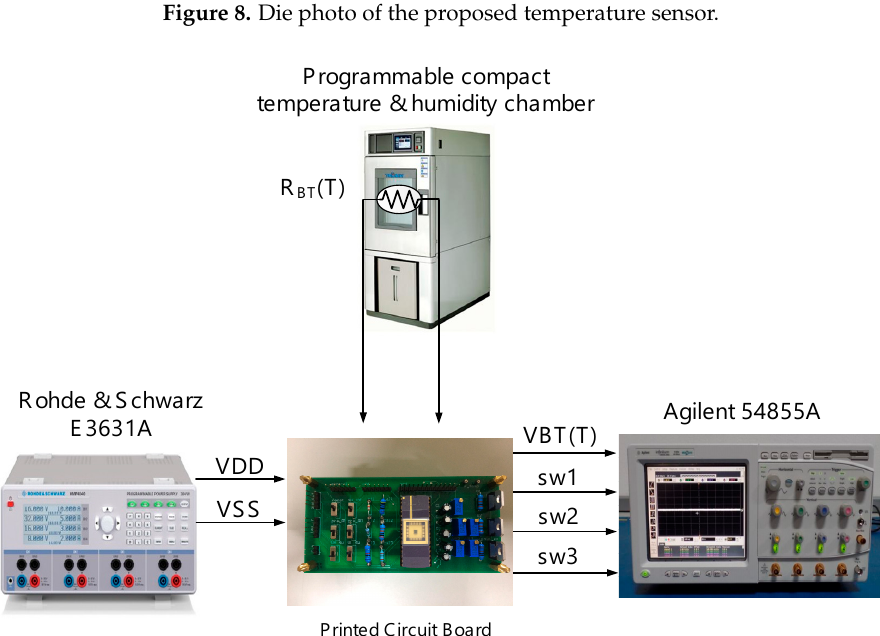
Figure 9. Measurement setup of the proposed Temperature sensor.